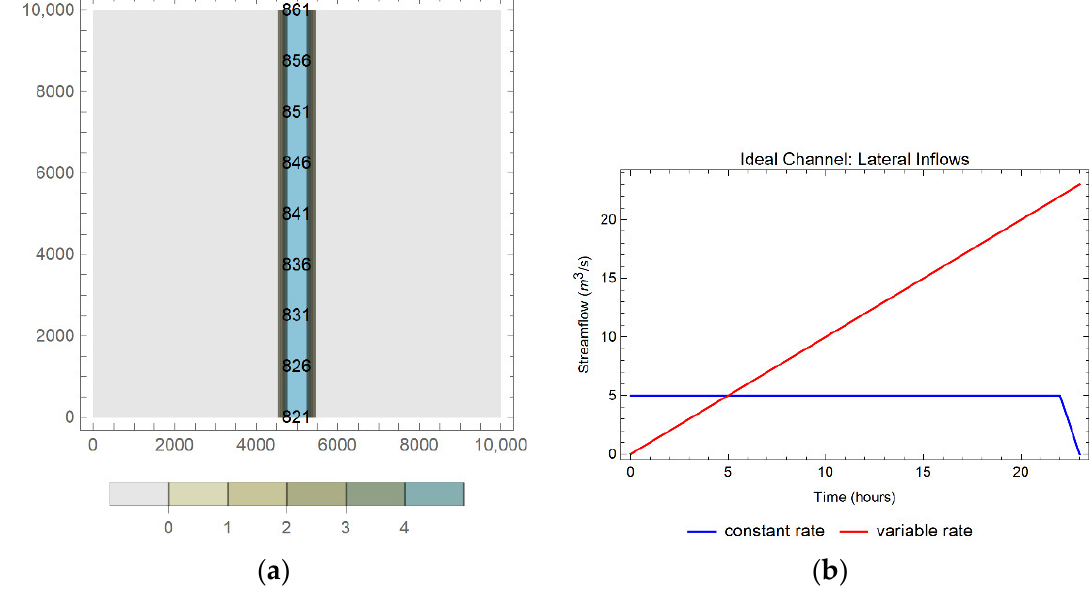
Figure 3. ( a ) Idealized channel domain with node numbers for time series output indicated within the domain. Depths (below MSL) are shown in blue with the light gray area of the domain showing the land with topography above MSL. ( b ) Idealized streamflows used to test the lateral inflows.